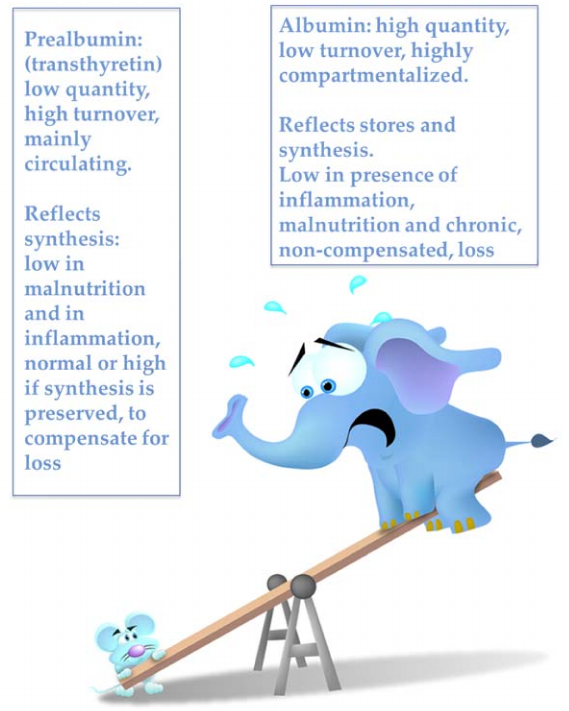
Figure 2. The albumin-prealbumin